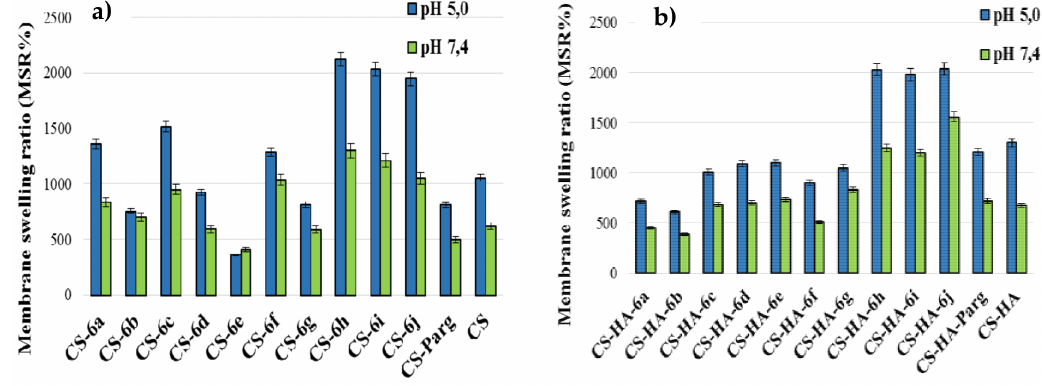
Figure 5. The membrane sweeling ratio (MSR) (%) of CS-ArgD ( a ) and CS-HA-ArgD ( b )